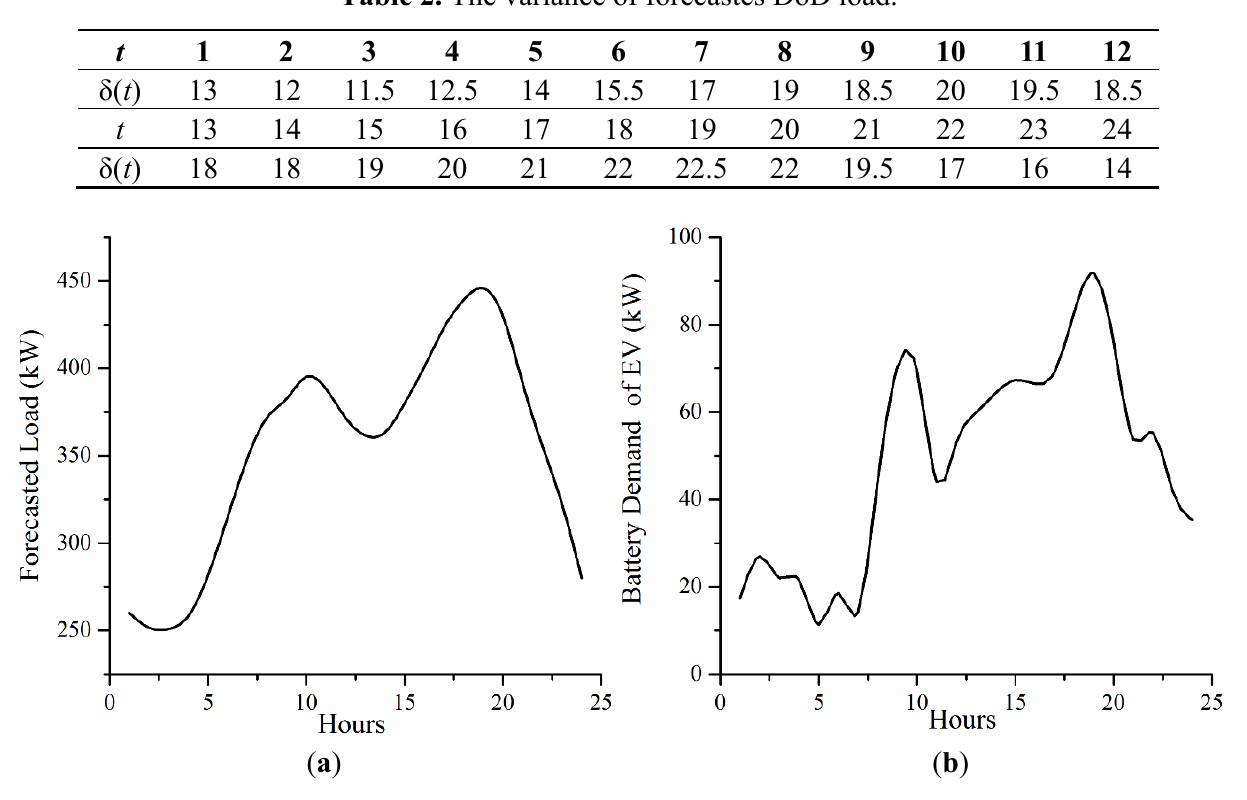
Table 2. The variance of forecastes DoD load.